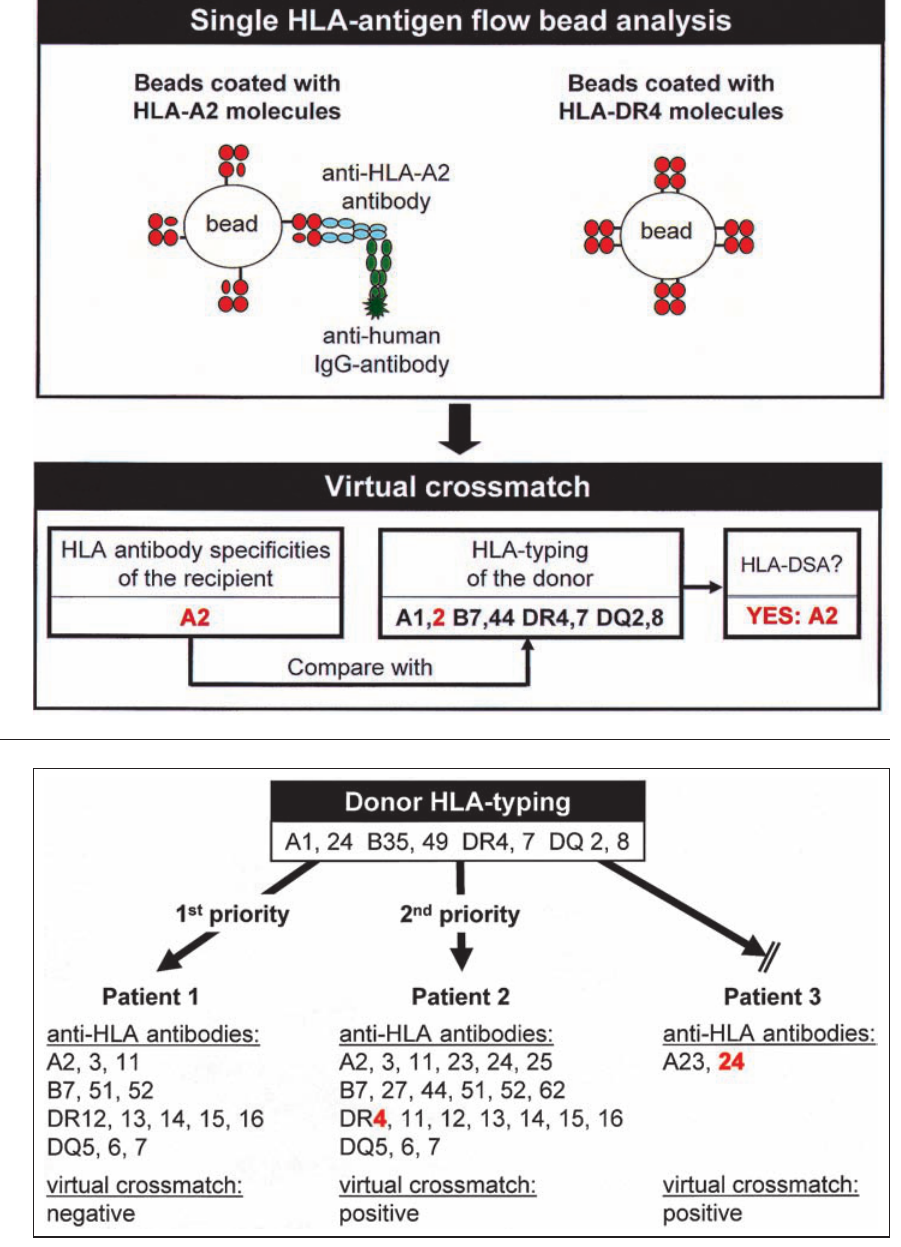
Single HLA flow bead analysis and the concept of virtual crossmatch. Single HLA flow beads consist of solid phase particles that carry only one specific HLA molecule on the surface. After incubation with the recipient’s serum a fluores- cent secondary antibody binding to human IgG antibodies is added. All individual beads (cur- rently covering around 150 different HLA mole- cules) are then analysed by flow cytometry. This allows assigning the specificity of HLA antibod- ies. By comparison with the HLA-typing of the donor, the presence of HLA-DSA can be deter- mined (i.e., virtual crossmatch).